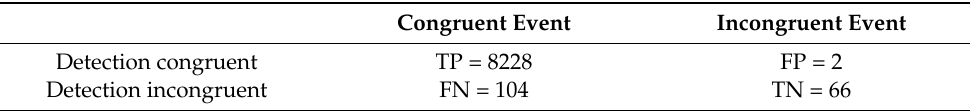
Table 7. Contingency table that assists with the detection of congruences in the Landsat 8 scene of the Doce River basin acquired in 2015 and consisting of 8400 tiles (TP—true positive, FP—false positive, FN—false negative, TN—true